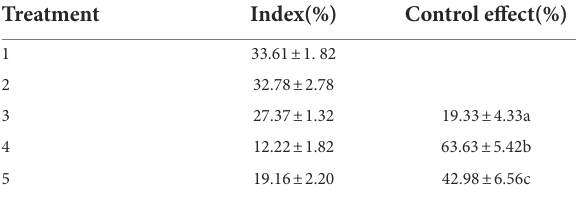
TABLE 7 The disease index and control effect of Fusarium crown and root rot of tomato.